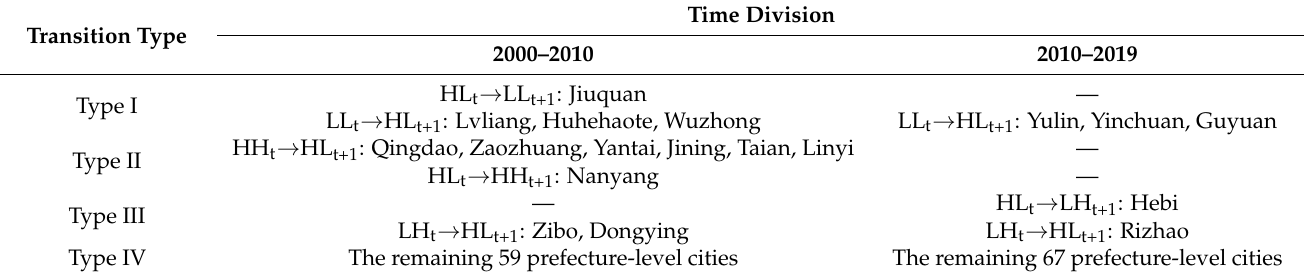
Table 3. LISA transition types of AWF grey of 73 prefecture-level cities in the Yellow River Basin from 2000 to